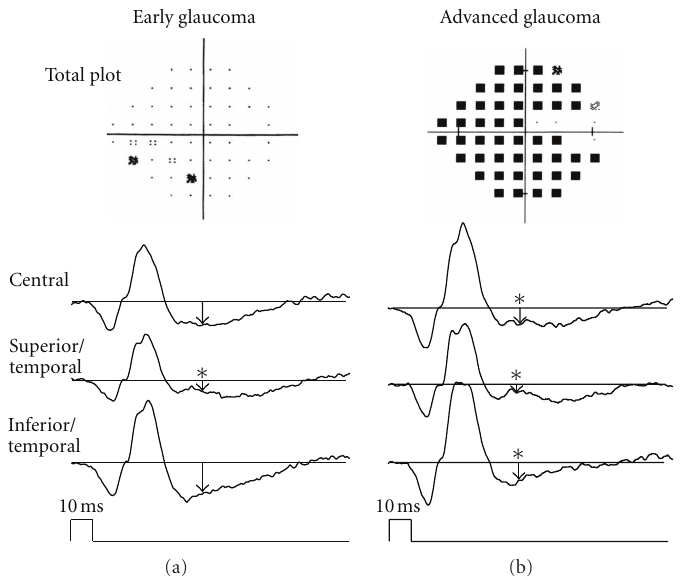
Figure 8: Representative cases of early (a) and advanced (b) glaucoma (reproduced with permission from [28]).